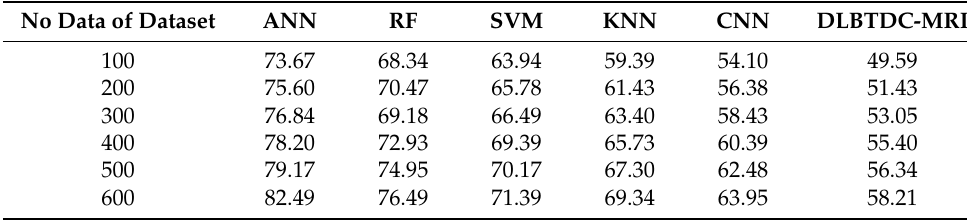
Figure 6. RMSE analysis of DLBTDC-MRI method with existing system. Figure 7. RMSE analysis of DLBTDC-MRI method with existing system. Table 4. RMSE analysis of DLBTDC-MRI method with existing